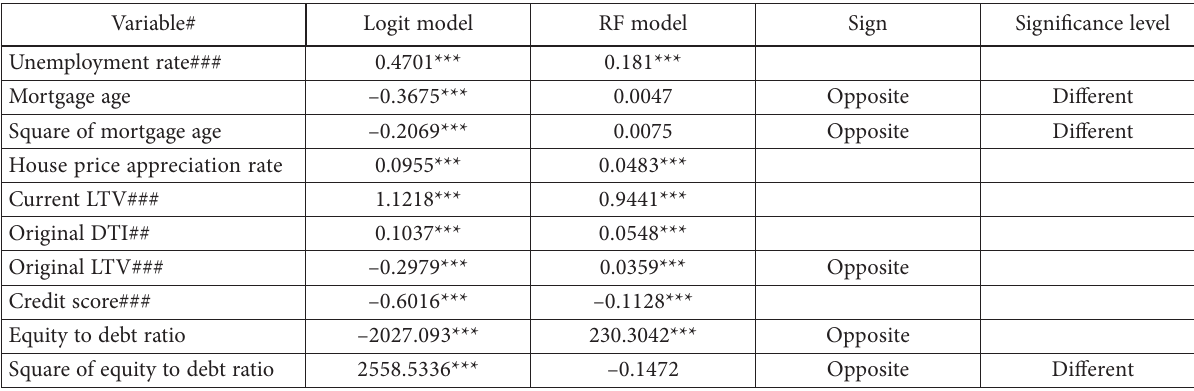
Table 6. Comparison of ME between logit regression and RF models